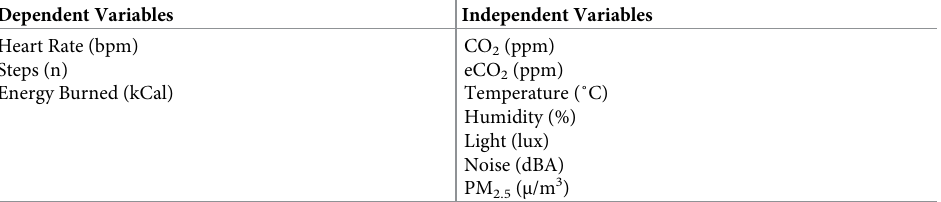
Table 4. Variables to be included in dynamic regression model.